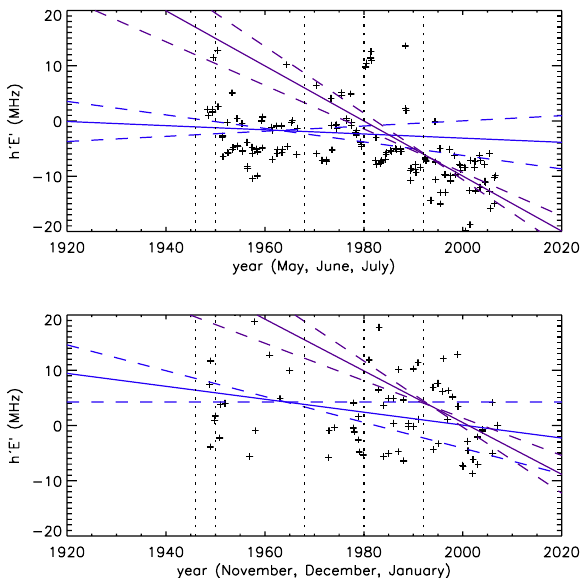
Fig. 6. Values, trends and uncertainties in f oE 0 from June (up- per panel) and December (lower panel). The trends are as fol- lows: June, − 0.02MHz decade − 1 ± 130%; December +0.01MHz decade − 1 ± 488%.